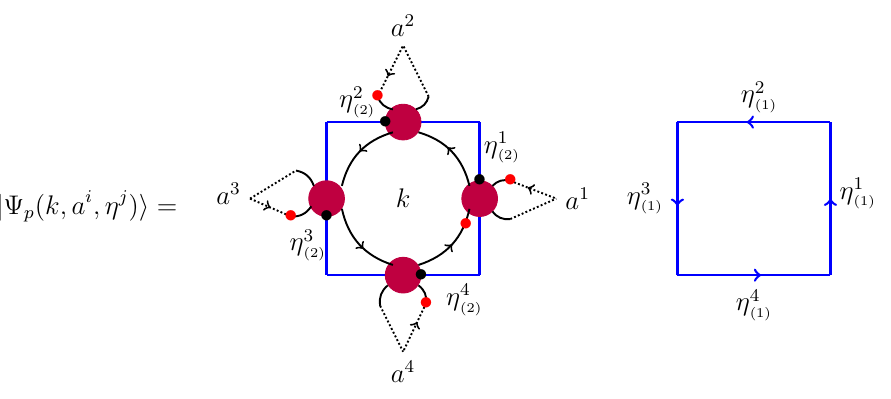
Figure 16 . Contribution associated to the face p to the state Ψ Γ . Note that the first diagram on the right side above is the tensor trace